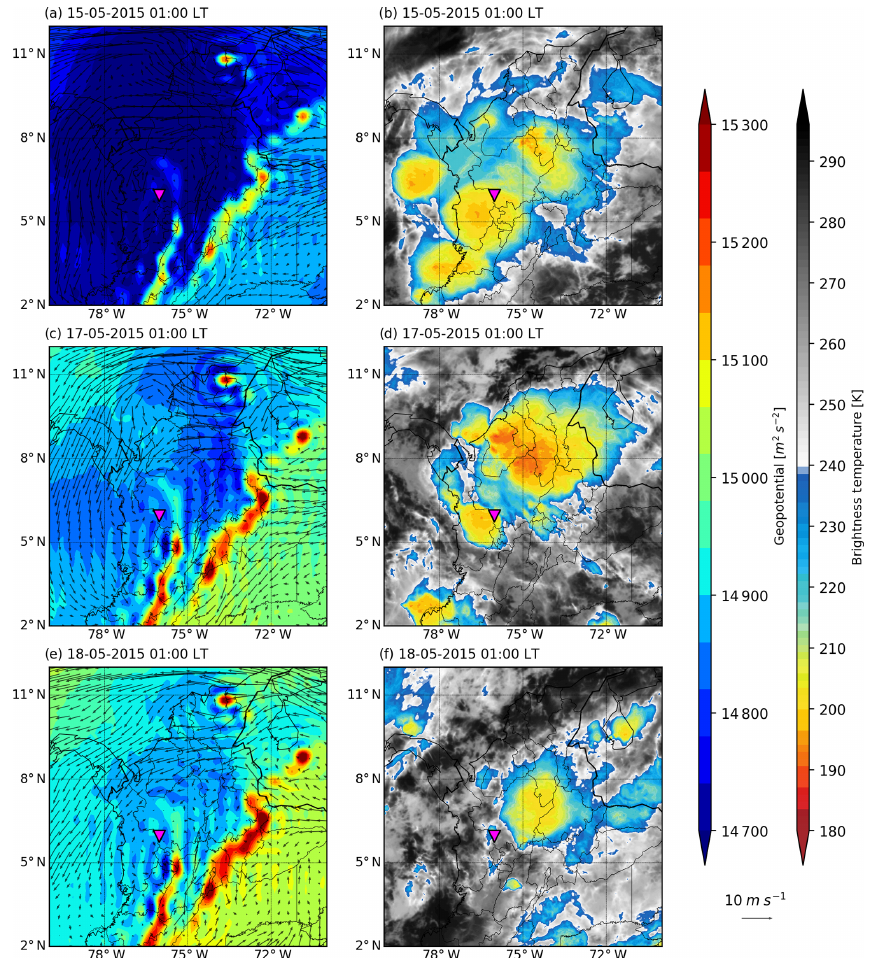
Figure 9. (a, c, e) show the ERA-Interim geopotential height at 700hPa (filled contours) and horizontal wind (vectors) for 15, 17, and 18 May 2015, all at 01:00LT, respectively. (b, d, f) show the GOES-13 brightness temperature for the same times as in (a, c, e)